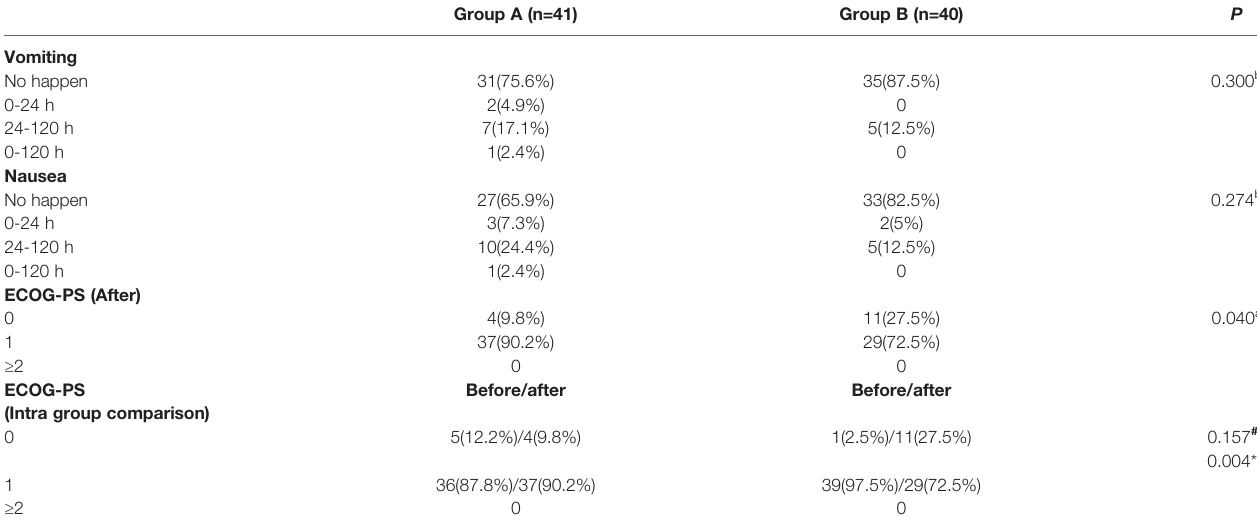
TABLE 2 | The ef fi cacy evaluation of antiemetic drugs.